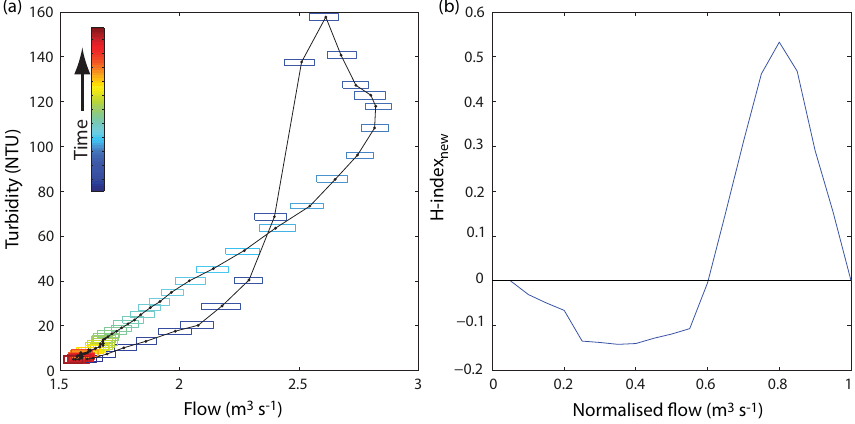
Figure 4. (a) The original storm, where the black line represents the median and the boxes the 5–95th percentiles of the uncertainty around the line, and (b) illustrates the HI new of the normalised